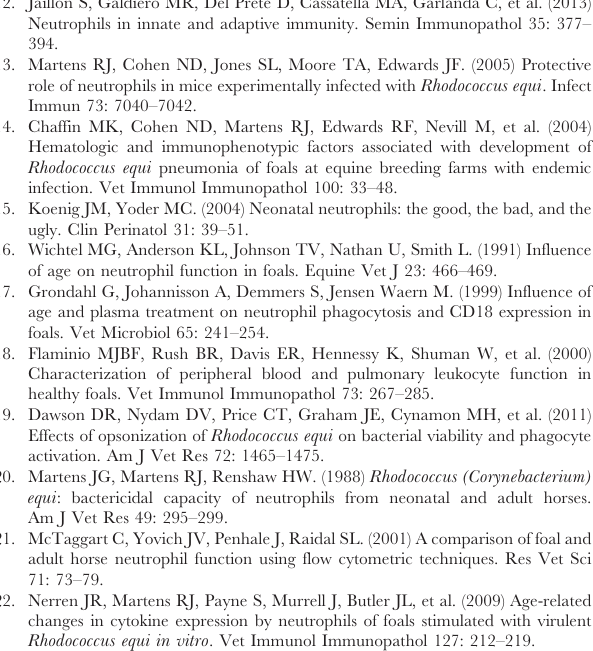
Table S1 Primer and probe sequences for amplification of various equine cytokines and b